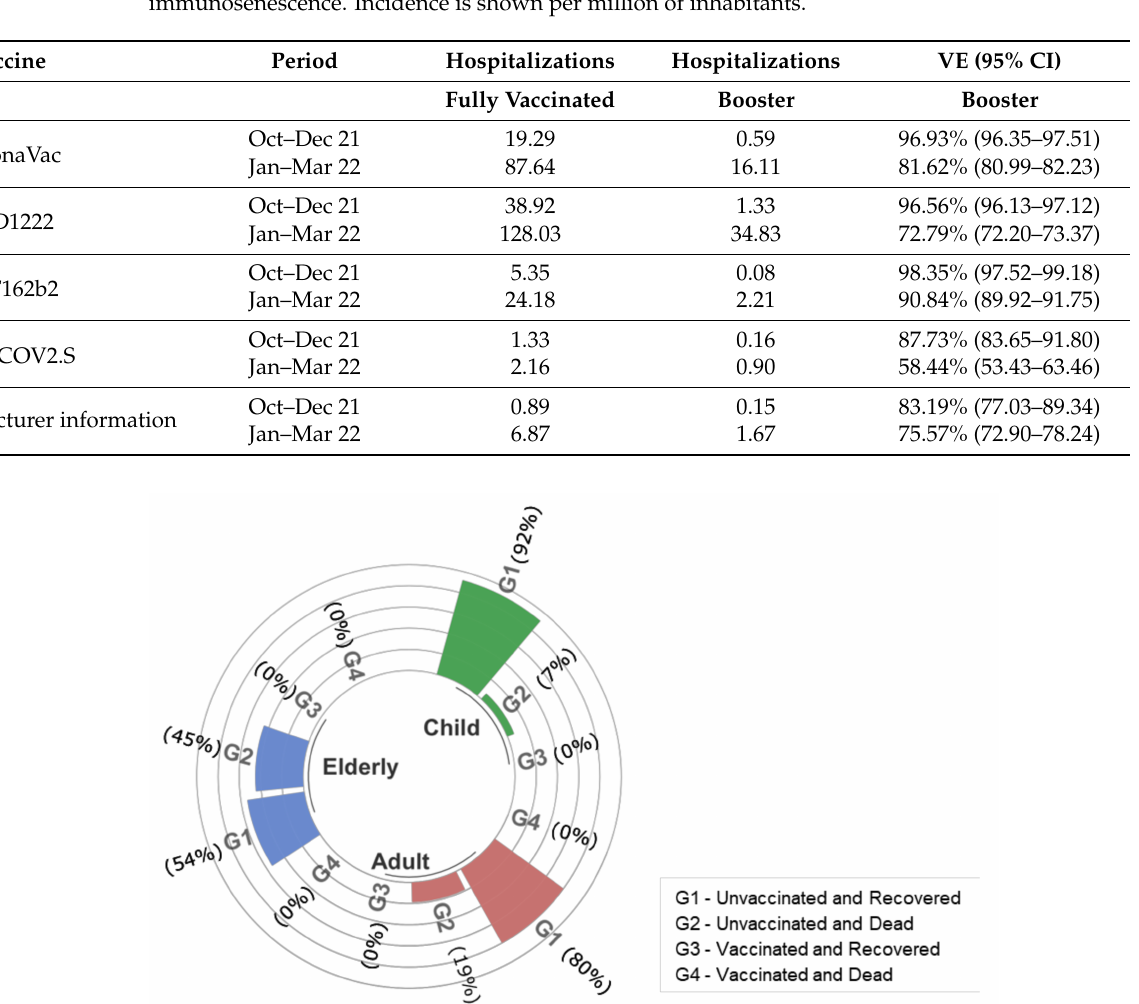
Table 1. Booster VE against SARS-CoV-2 for two different periods of time, without considering the immunosenescence. Incidence is shown per million of inhabitants.